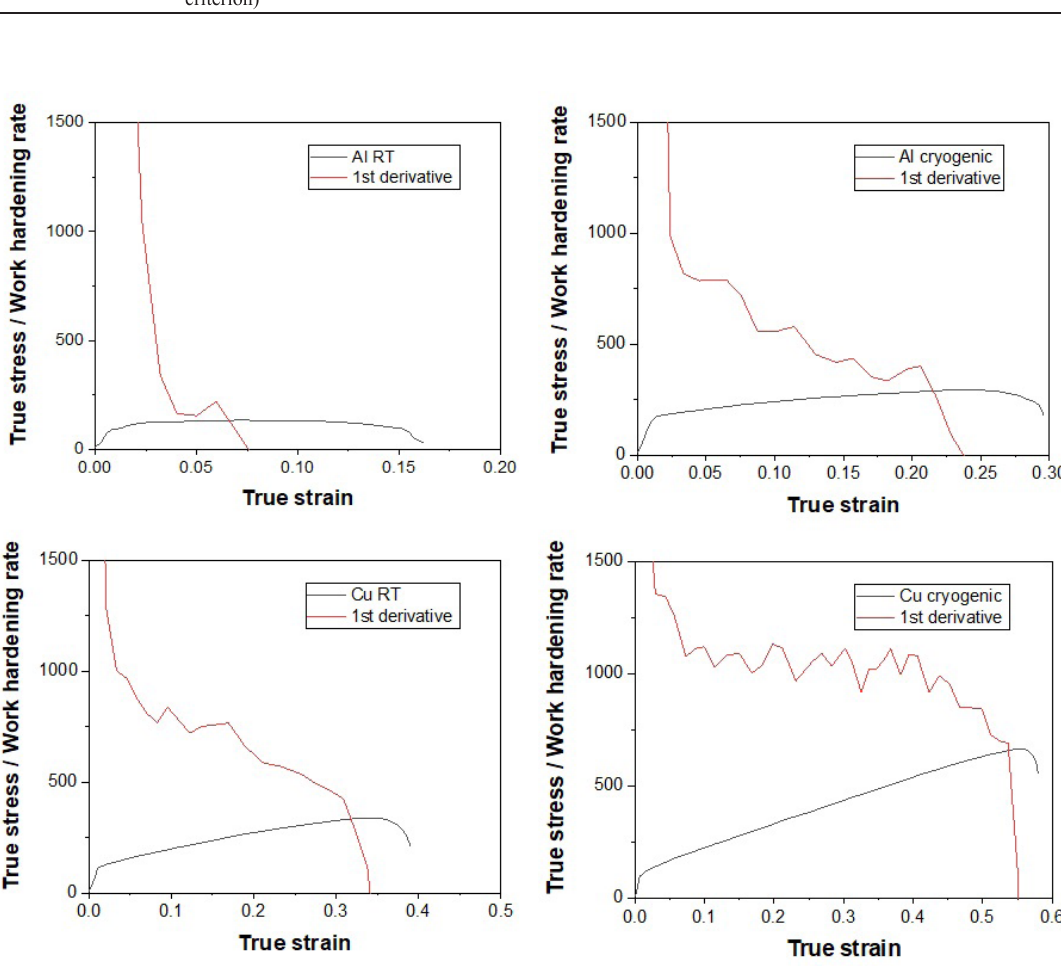
Figure 5. Engineering Stress-strain behavior at RT and CT for cp aluminum and cp copper (left column) and True stress and work hardening rate as a function of true strain (Considerè criterion) (right